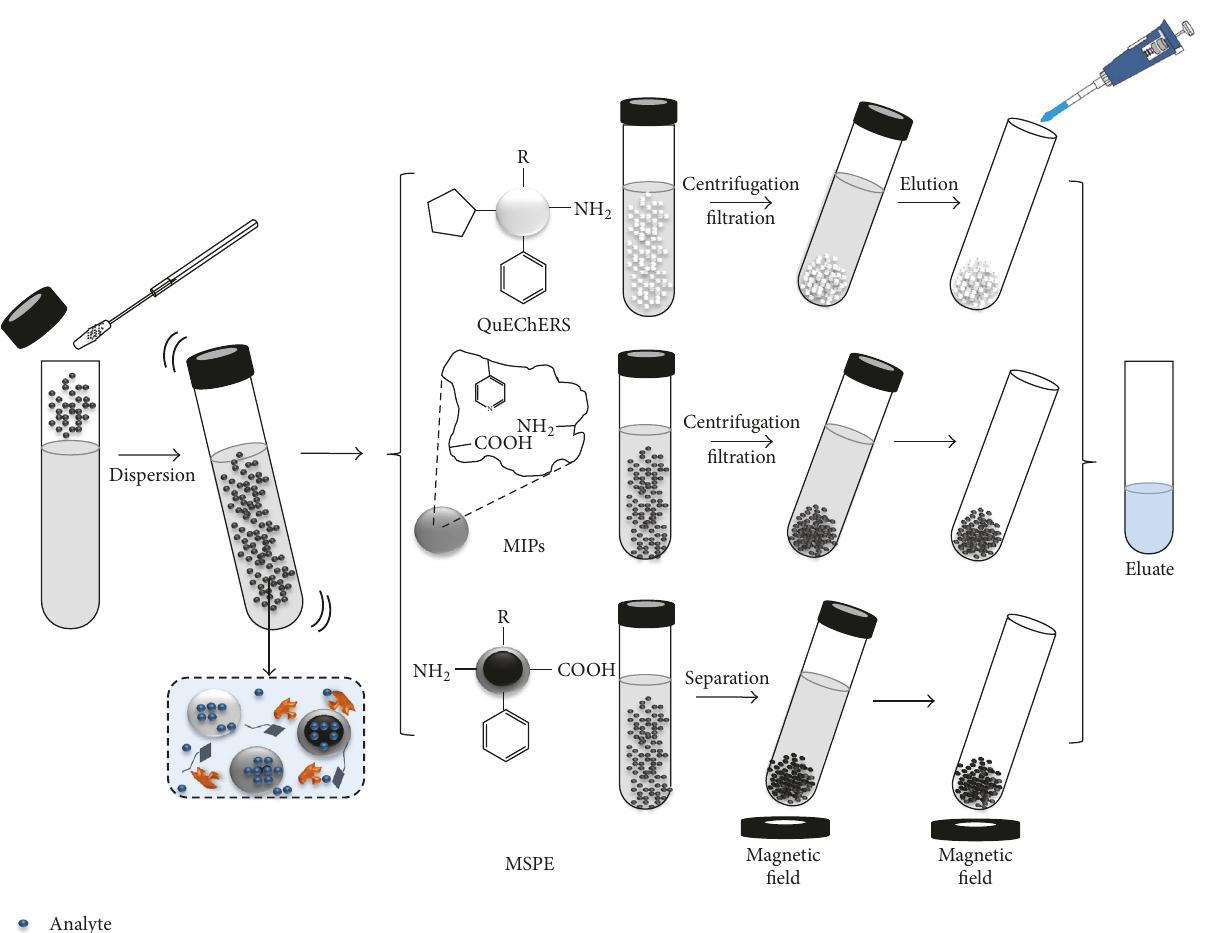
Figure 2: Scheme of dispersion solid phase extraction applied for different